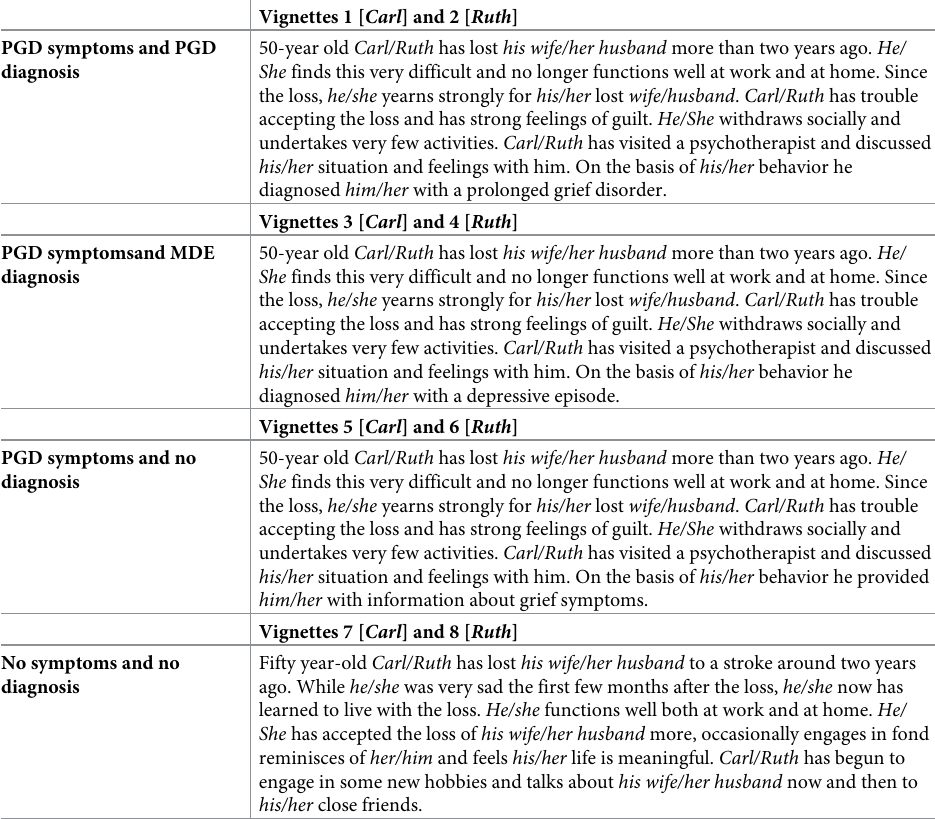
Table 1. Content of 8 vignettes varying ‘mental health condition’ and ‘gender of bereaved person